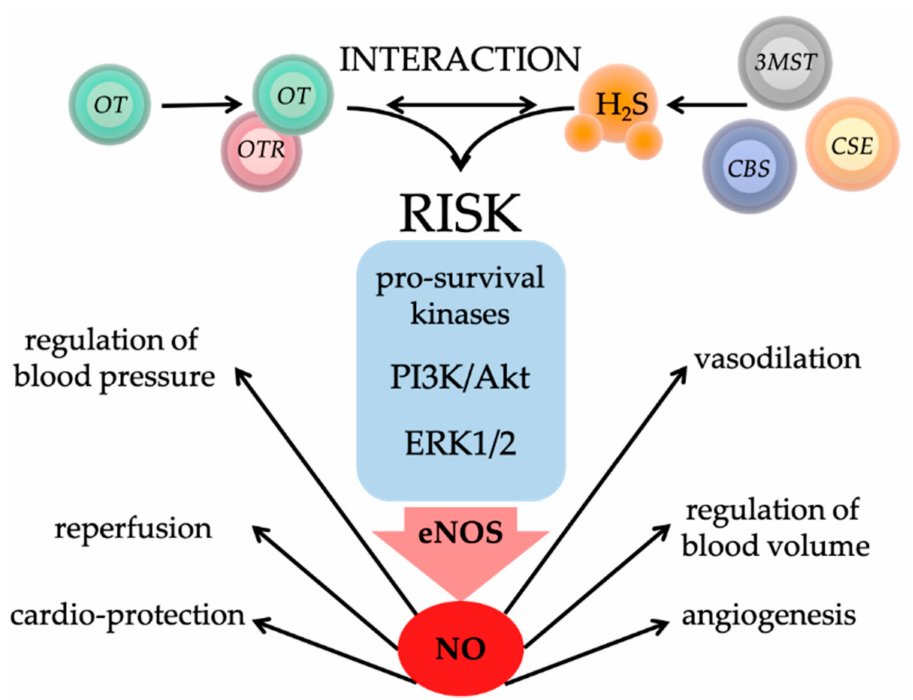
Figure 4. Interaction of Oxytocin/Oxytocin Receptor (OT/OTR) and Hydrogen Sulfide (H 2 S) via the Reperfusion Injury Salvage Kinase (RISK) Pathway. Through OT binding to the OTR, and/or H 2 S production from cystathionine γ -lyase (CSE), cystathionine- β -synthase (CBS), or 3-mercaptopyruvate sulphurtransferase (3MST), pro-survival kinases of the RISK pathway can be activated: Phosphatidylinositol 3-kinase/ Protein Kinase B (PI3K/Akt) and extracellular signal- regulated kinase 1/2 (ERK1/2). These kinases stimulate endothelial nitric oxide synthase (eNOS) and subsequently the release of nitric oxide (NO). NO activates regulation of blood pressure and blood volume, reperfusion, vasodilation, angiogenesis, and finally cardio-protection. H 2 S: hydro- gen sulfide; CSE: cystathionine γ -lyase; CBS: cystathionine- β -synthase; 3MST: 3-mercaptopyruvate sulphurtransferase; OT: oxytocin; OTR: oxytocin receptor; RISK: reperfusion injury salvage kinase; PI3K: Phosphatidylinositol 3-kinase; Akt: Protein Kinase B; ERK1/2: extracellular signal-regulated kinase 1/2; eNOS: endothelial nitric oxide synthase; NO: nitric oxide. Illustrations of the circle shapes and spheres were taken from the Library of Science and Medical Illustrations (somersault18:24,